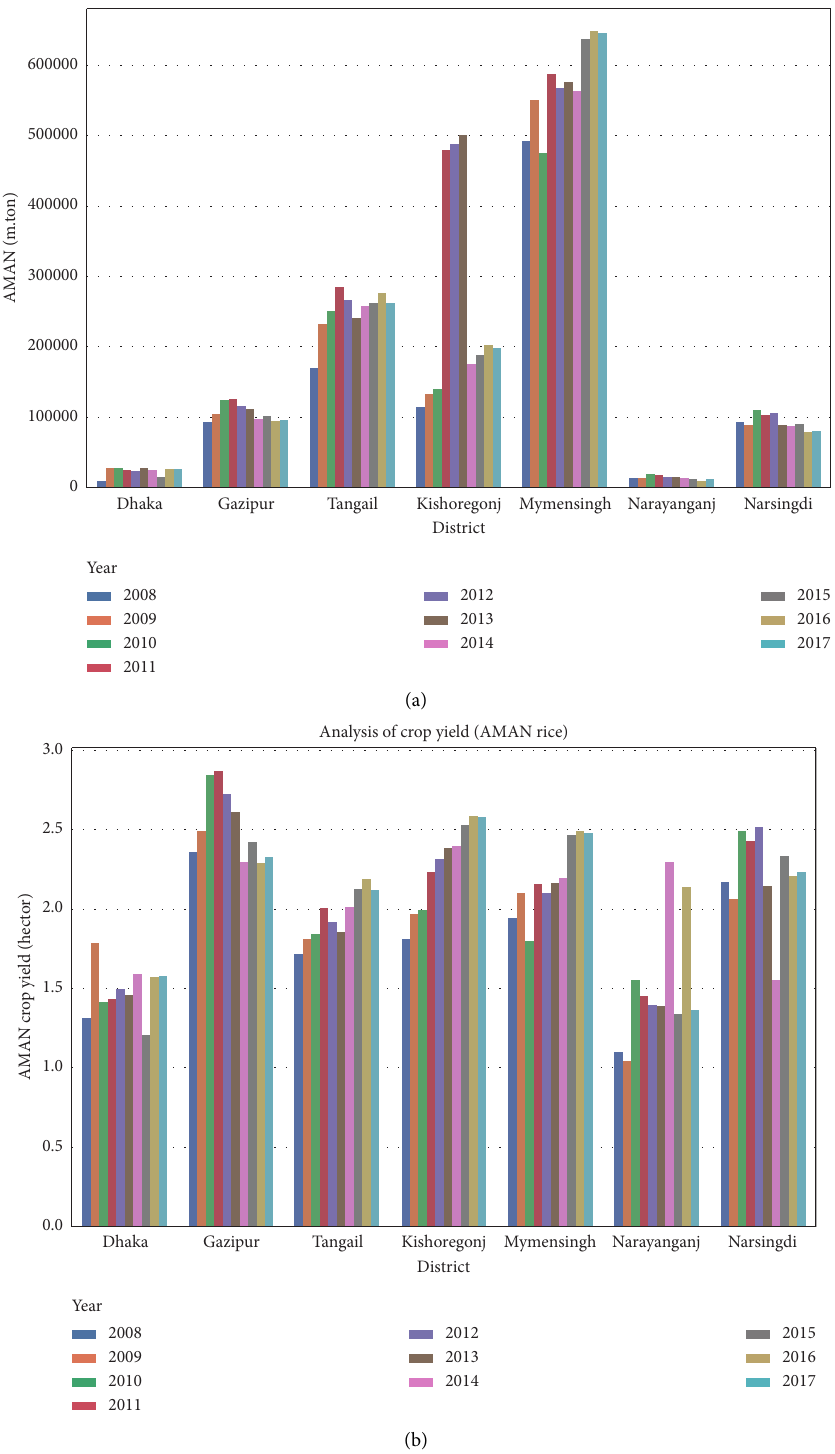
Figure 6: Data analysis of Aman rice. (a) Crop production for Aman rice. (b) Crop yield for Aman